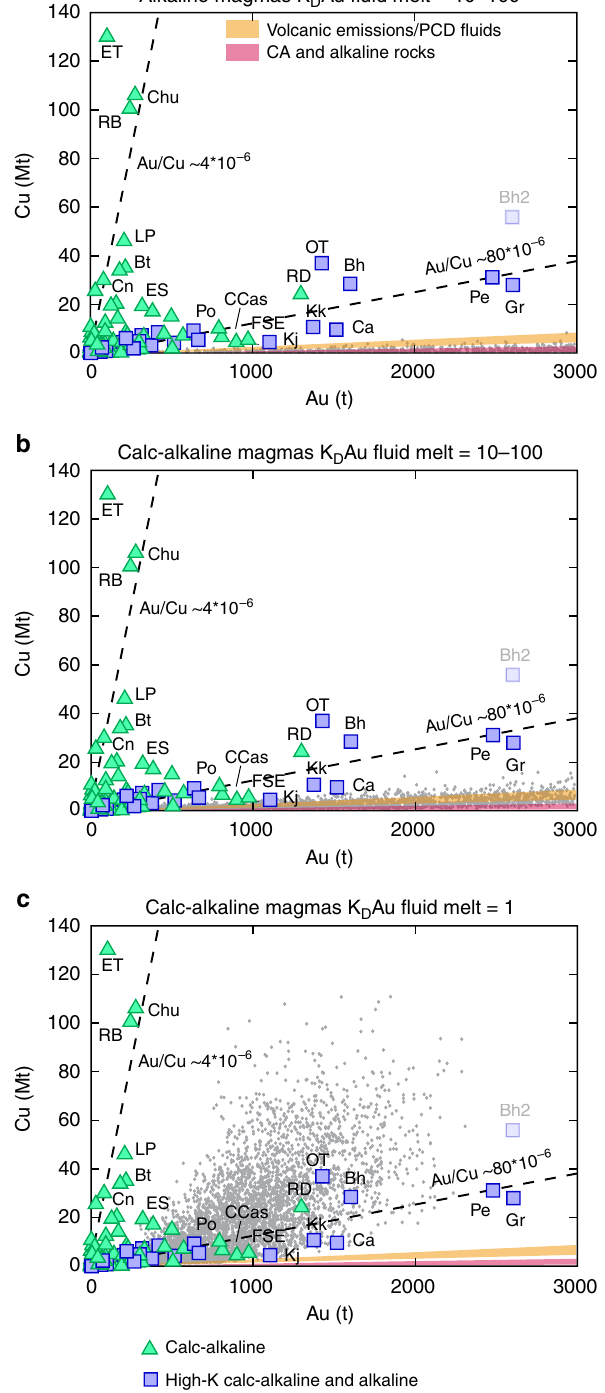
Fig. 3 Monte Carlo simulations (grey dots; >7000) of the Au and Cu endowments obtained for different fl uid-melt K D values of Au. Using a